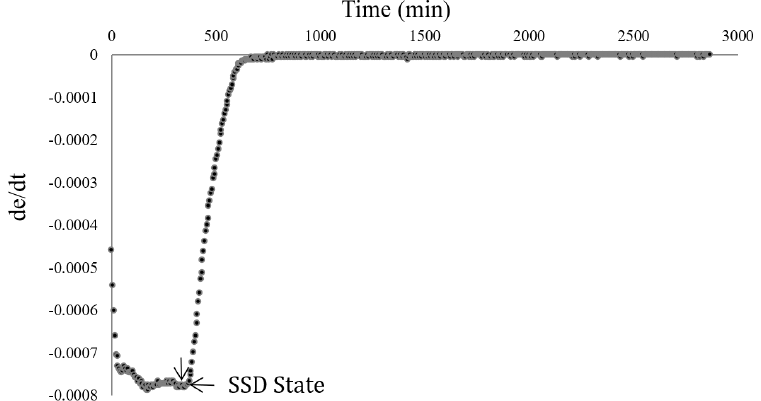
Figure 2. Drying curve of an RCA with respect to time to obtain the SSD